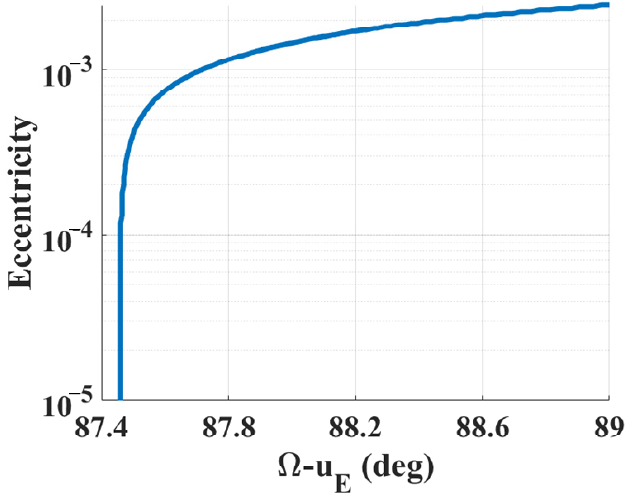
Figure 10. Distribution of